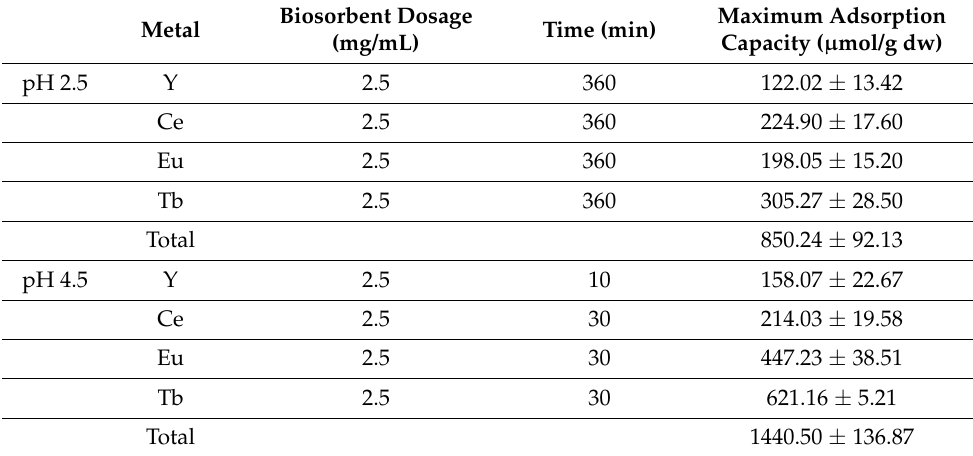
Table 1. Maximum adsorption capacity ( µ mol/g dw) from quaternary metal systems at pH 2.5